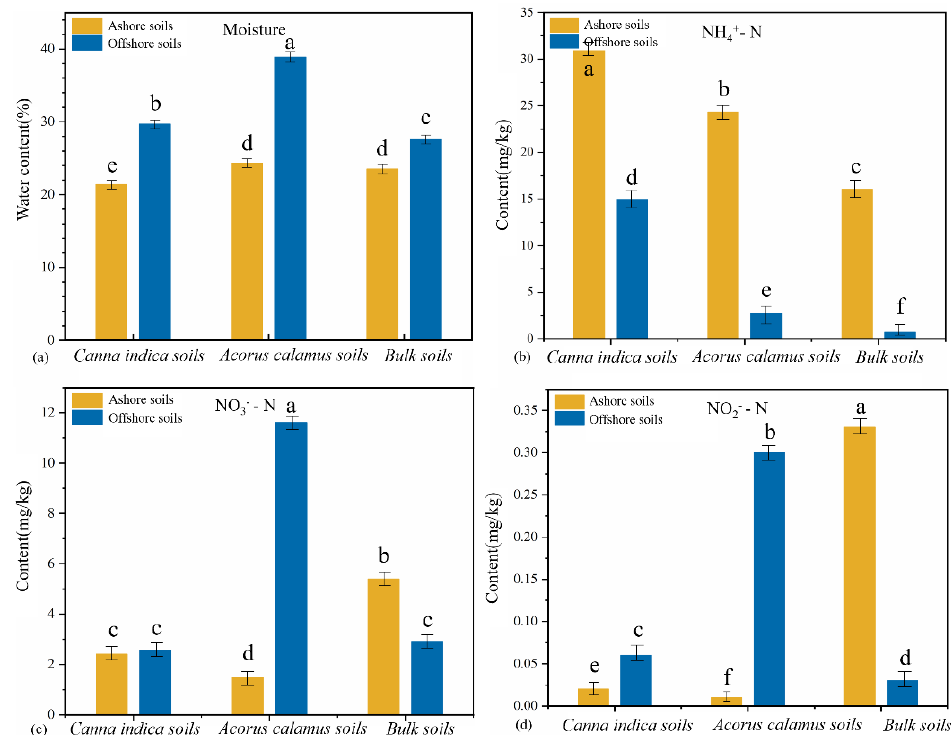
Figure 2. Physiochemical properties of Acorus calamus and Canna indica rhizosphere and bulk soil. ( a ) Soil moisture content among rhizosphere and bulk soils; ( b ) Ammonium (NH 4+ -N) concentration; ( c ) nitrate (NO 3 − -N) concentration; ( d ) nitrite (NO 2 − -N) concentration. Letters (a, b, c, d, e and f) above the bars were based on Waller-Duncan analysis at significance level of 0.05.